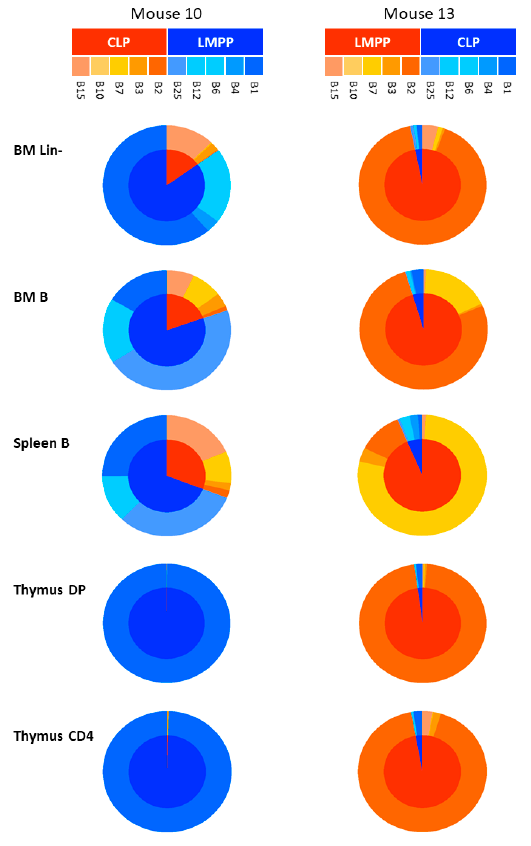
Figure 7. Sunburst plots representing the contribution of LMPP/CLP progenitors to the reconstitution of lymphoid populations. The BC composition of BM, spleen and thymus of two representative “mirror” mice (10 and 13) is shown. Each BC is represented by a color code. Orange to red BCs are present in CLP of mouse 10 and in LMPP of mouse 13. The blue BCs are present in LMPP of mouse 10 and in CLP of mouse 13. The inner circles represent the dominant BC color within a mentioned tissue. The blue color in mouse 10 is dominant and associated with LMPP subset. In contrast, the red color is dominant in mouse 13 and associated also with the LMPP subset. The outer circle details individual BCs found in each cell type.